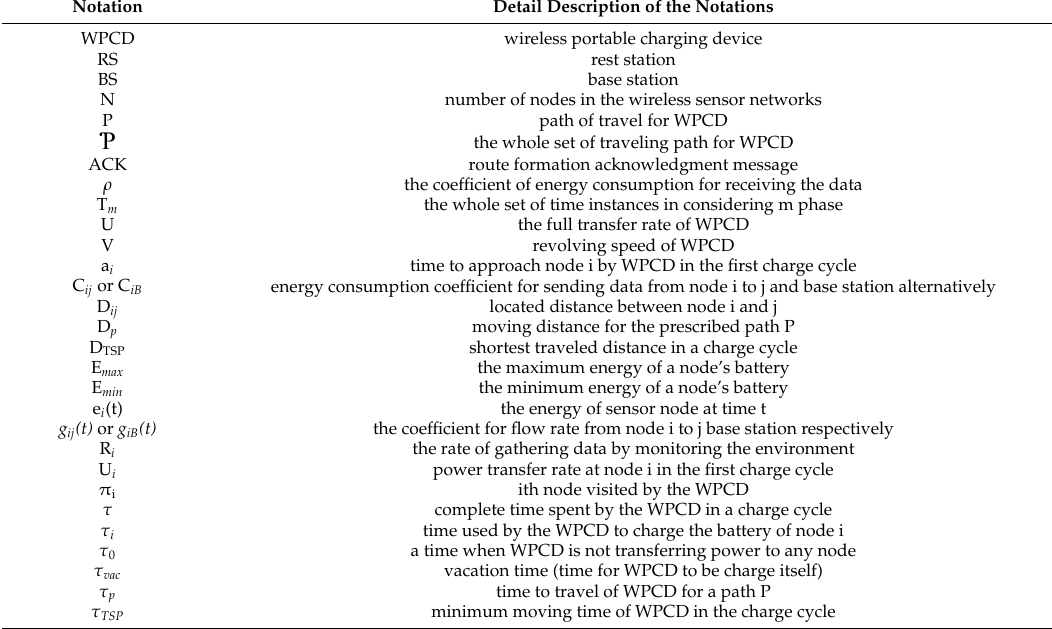
Table 1. Notations for the entire network model.